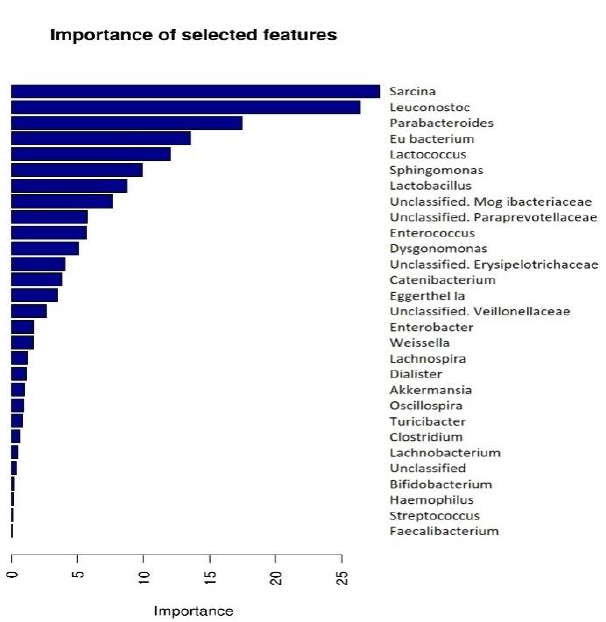
Figure 5. Microbiome analysis of each of the 4 groups according to nutritional intake (Part 2) ( a ) Phylum-level microbial composition analysis of the 3 groups of bodybuilders and the sedentary group. ( b ) Results of α-diversity analysis. Group 1 showed no significant differences compared with the sedentary group. Groups 2 and 3 showed significant differences compared to the sedentary group in the number of identified species (Group2/Group4: * p = 0.007; Group3/Group4: * p = 0.014), Chao1 (Group2/Group4: ** p = 0.004; Group3/Group4: * p < 0.011), ACE (Group2/Group4: * p = 0.007; Group3/Group4: * p = 0.018), and Jackknife (Group2/Group4: ** p = 0.004; Group3/Group4: * p = 0.011). ( c ) Redundancy analysis (RDA) showing separation between the groups in GENUS units and OUT (operational taxonomic units) units. ( d ) Effect size (LEfSe) was measured via LDA. The standard test for statistical significance was combined with additional tests for biological consistency and related effects to analyze taxonomic group, which was most likely to account for the differences between the groups at the genus level. Fecalibacterium was specified, in addition to Group 1: Haemophilus , Streptococcus ; Group 2: Bifidobacterium ; and Group 3: unclassified bacteria. ( e ) The genus-level microbial patterns of the different groups of bodybuilders were visualized using a heat map. The individual samples in the groups are displayed. Color intensity was normalized to show the relative proportions of the four groups. The color range from white to red indicates the relative value (0–8) of all microorganisms. White color indicates that the genus is not detected or is not abundant, and deepening shades of red indicate increasing abundance. ( f ) Forest ranking based on average factor importance.